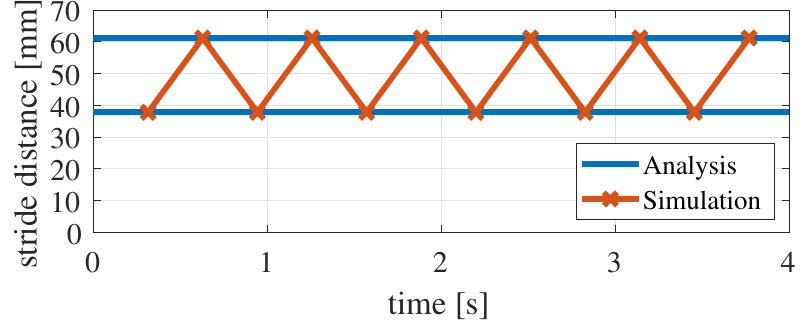
Figure 13. The time variation of the stride length in the simulation for counter-clockwise turning locomotion. The simulation results show that the robot walks with different stride lengths in each half